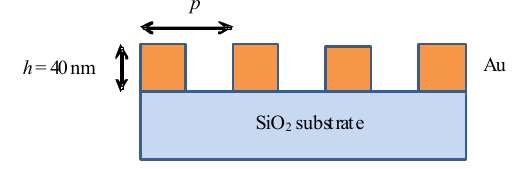
Fig. 1 Schematic diagram of the fabricated sensor structure.